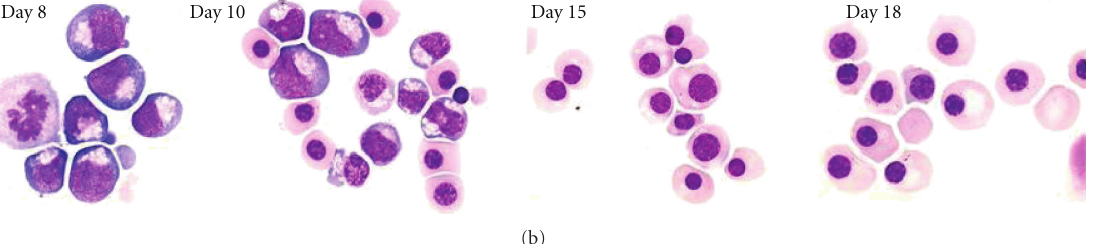
HPLC analysis ( n = 4) performed on erythroid cells derived from FL revealed mainly fetal hemoglobin (Hb)